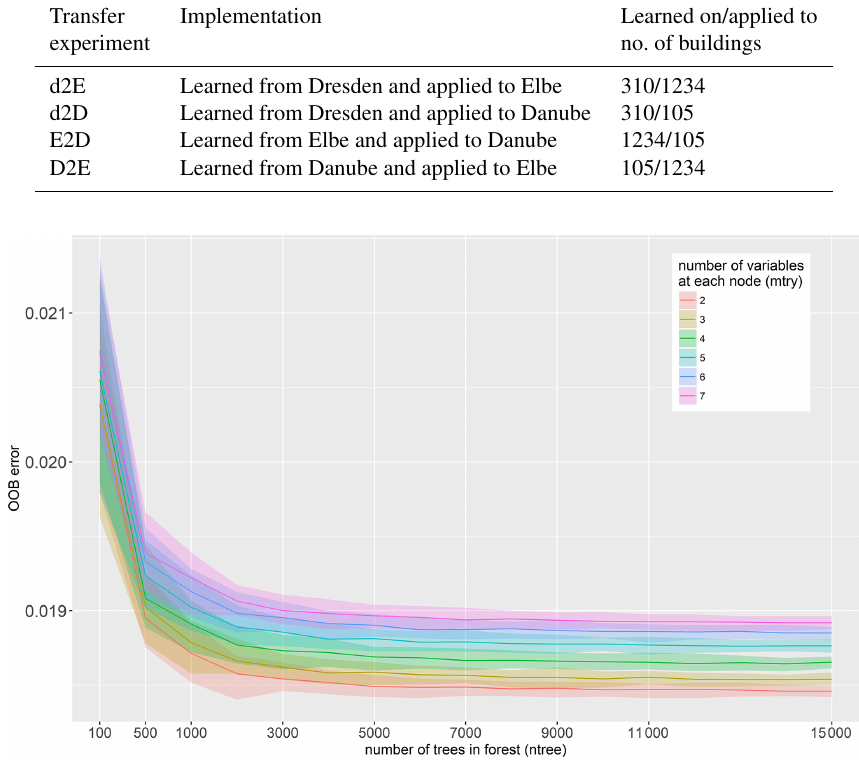
Table 3. Computational experiments for transfer applications.